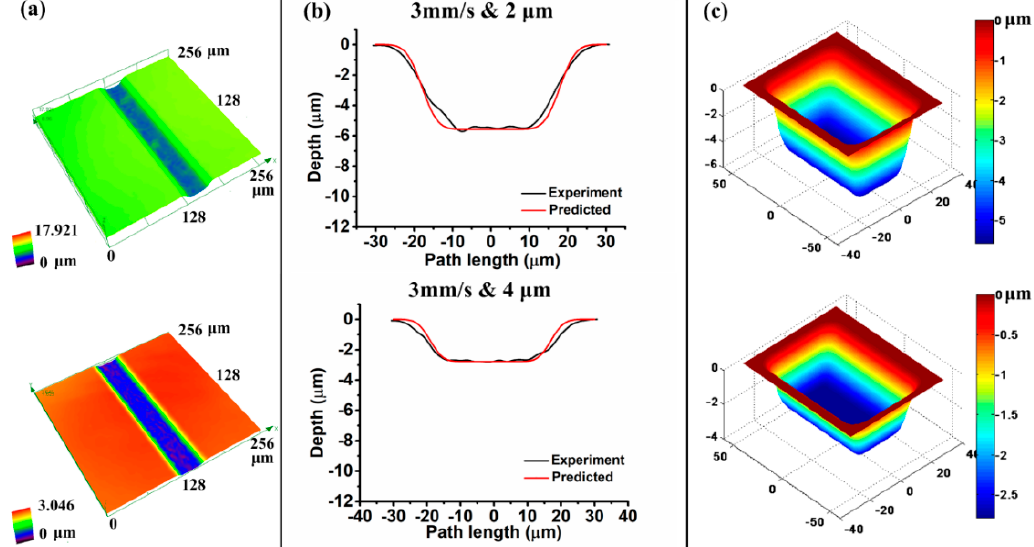
Figure 8. The comparison between experimental and predicted micro-channels for different adjacent intervals: ( a ) measured micro-channels, ( b ) comparison of cross-sectional profiles, and ( c ) predicted micro-channels.